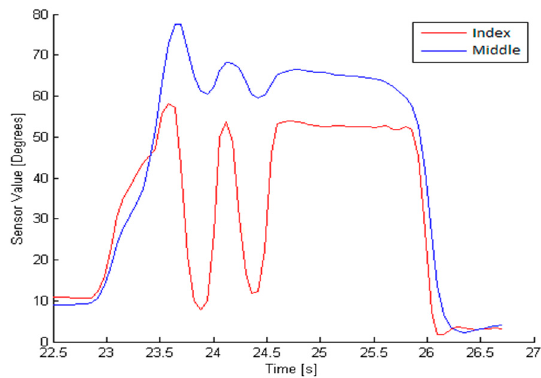
Figure 5. Sensor values during movement 2. There should be no motion in the middle finger, because only the index finger should participate.